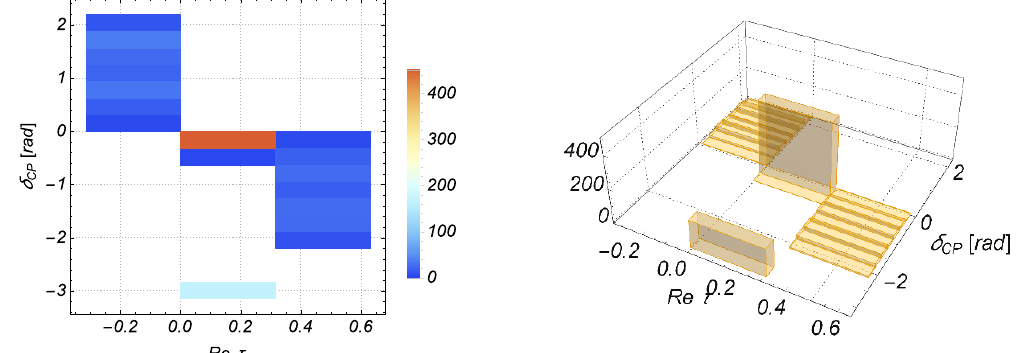
Figure 10 . Distributions of the CP-violating phase δ CP vs. real part of complex structure modulus Re τ for Im τ = 1 . 9 in Pattern III.